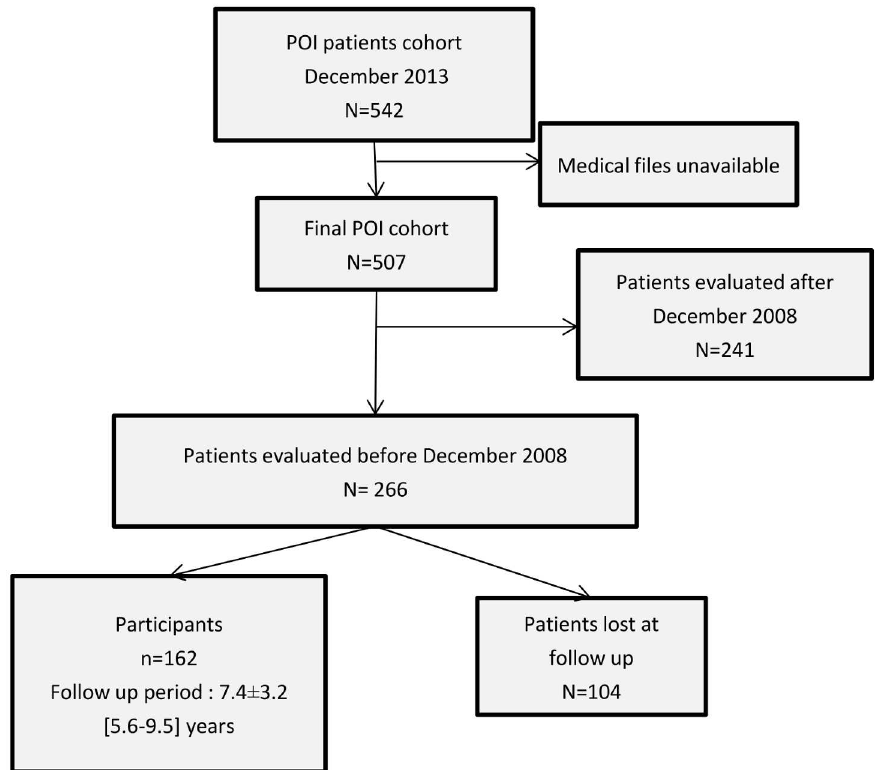
Fig 1. Flow chart of the POI patients included in the